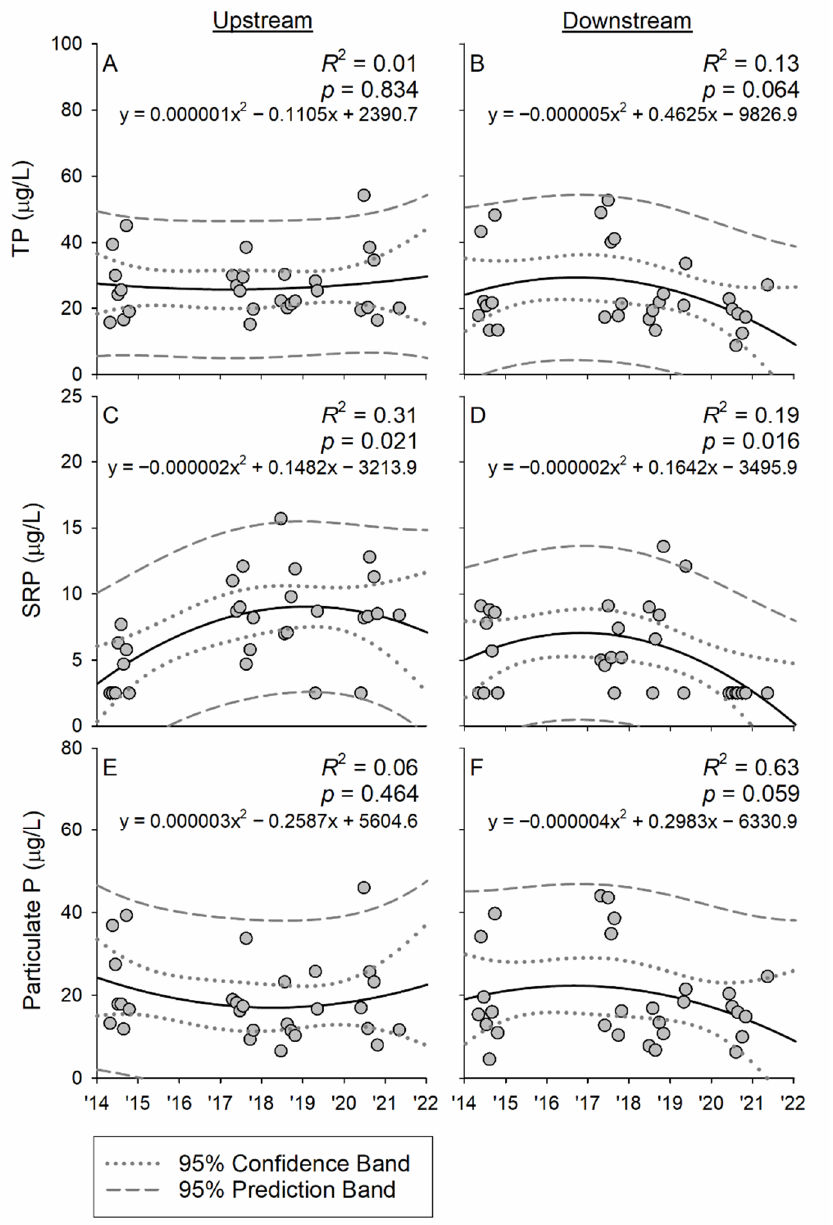
Figure 8. Bear Creek phosphorus regressions of TP ( A , B ), SRP ( C , D ), and particulate P ( E , F ) at upstream ( A , C , E ) and downstream ( B , D , F ) sites. Legend below E applies to all panels.